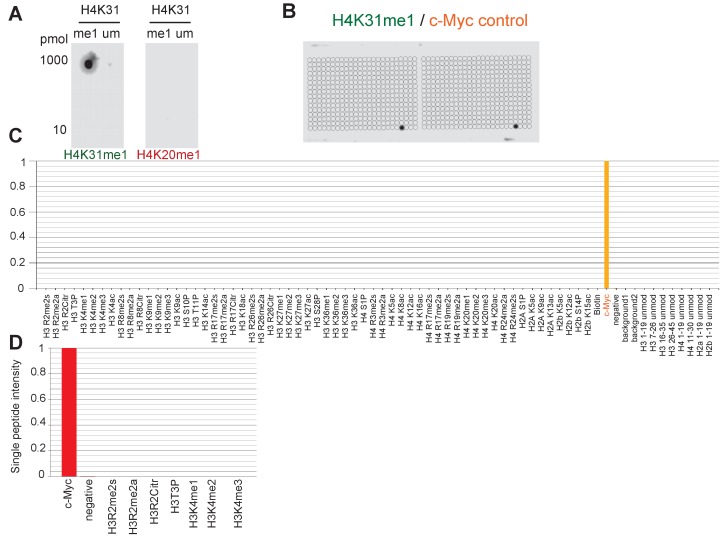
Specific binding of homemade H4K31me1-directed antibody to H4K31 methylated peptide in vitro.(a) Peptides with monomethylated (me1) and unmodified (um) H4K31 were spotted at 10 or 1000 pmol and detected with homemade H4K31me1-directed antibodies or with the control anti-H4K20me1 (described by Sautel et al. [2007]). (b) A 59 PTM-containing MODified Histone Peptide Array (from Activemotif) was incubated with H4K31me1-directed antibody (1/1000) as well as the internal control c-Myc antibody (1/2000) and (c–d) the signals were analyzed according to the manufacturer's instructions (see Materials and methods).